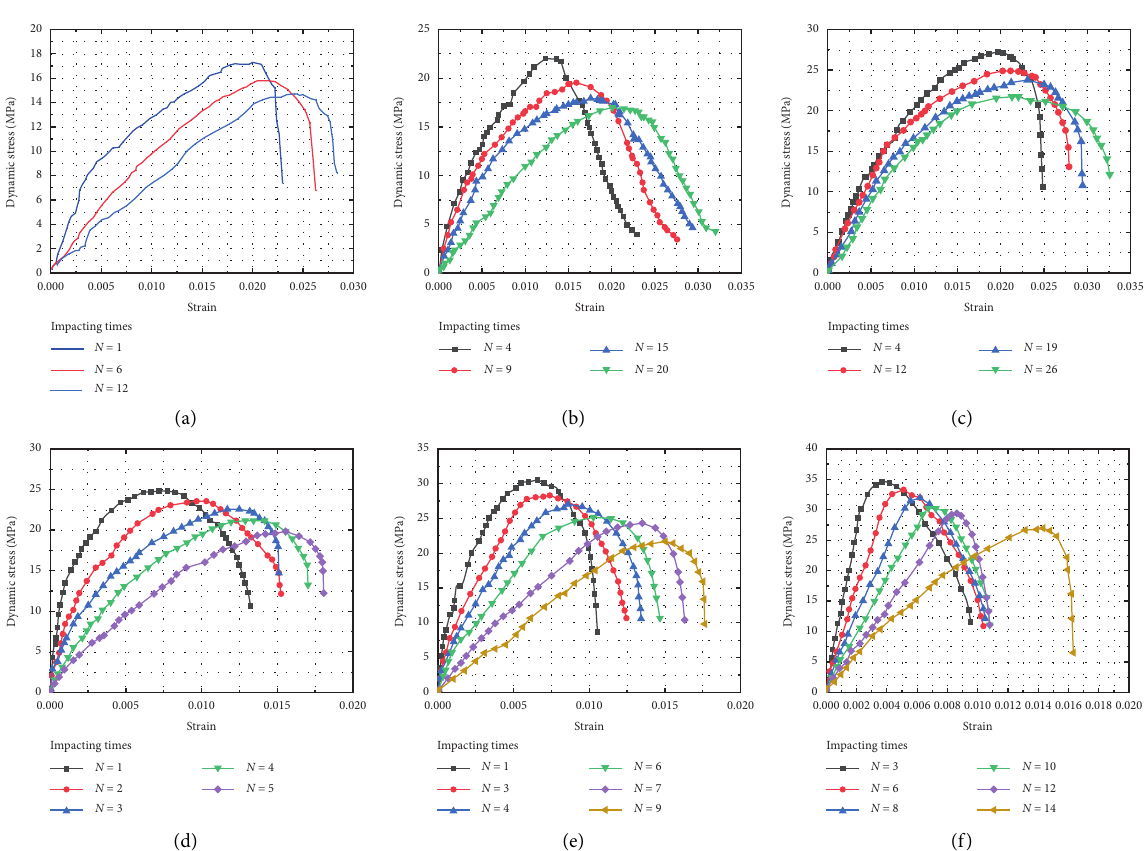
Figure 5: The dynamic stress-strain curves of coal under different axial stresses and cyclic impacts: (a) axial stress is 8 MPa, no. XZY1-2; (b) axial stress is 5MPa, no. XZY2-1; and (c) axial stress is 2 MPa, no. XZY3-3, for the Zhaogezhuang burst-resistant coal specimen; (d) axial stress is 8MPa, no. YJ1-1; (e) axial stress is 5MPa, no. YJ2-3; and (f) axial stress is 2 MPa, no. YJ2-3, for the Qianqiu burst-prone coal